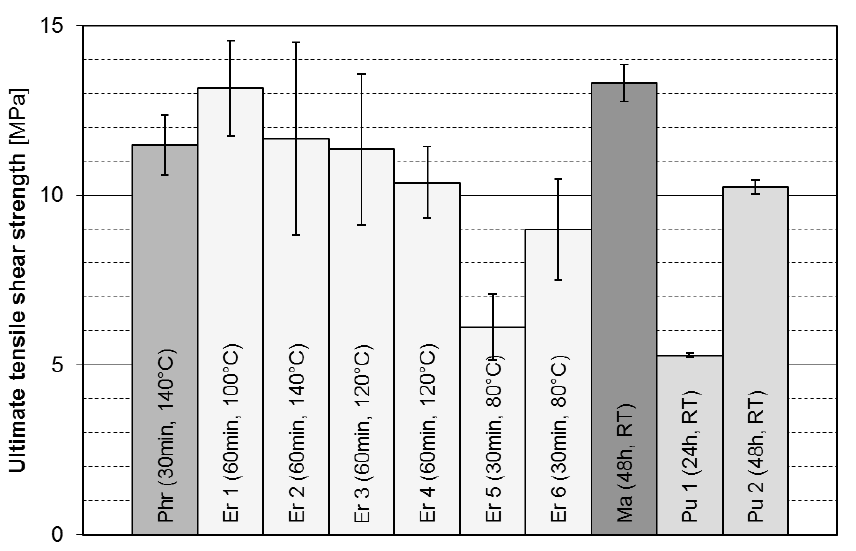
Figure 5. Static single-lap tensile shear strength of different adhesive systems (averages and standard deviations of two specimens) [25].